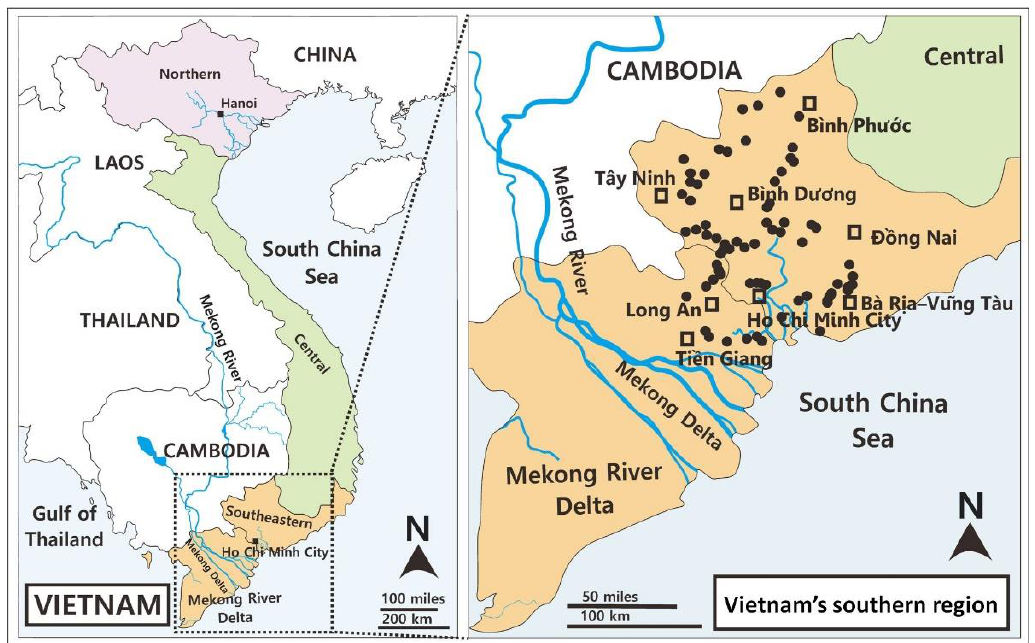
Figure 1. The map of southern Vietnam showing the locations of sampling sites (black dots).